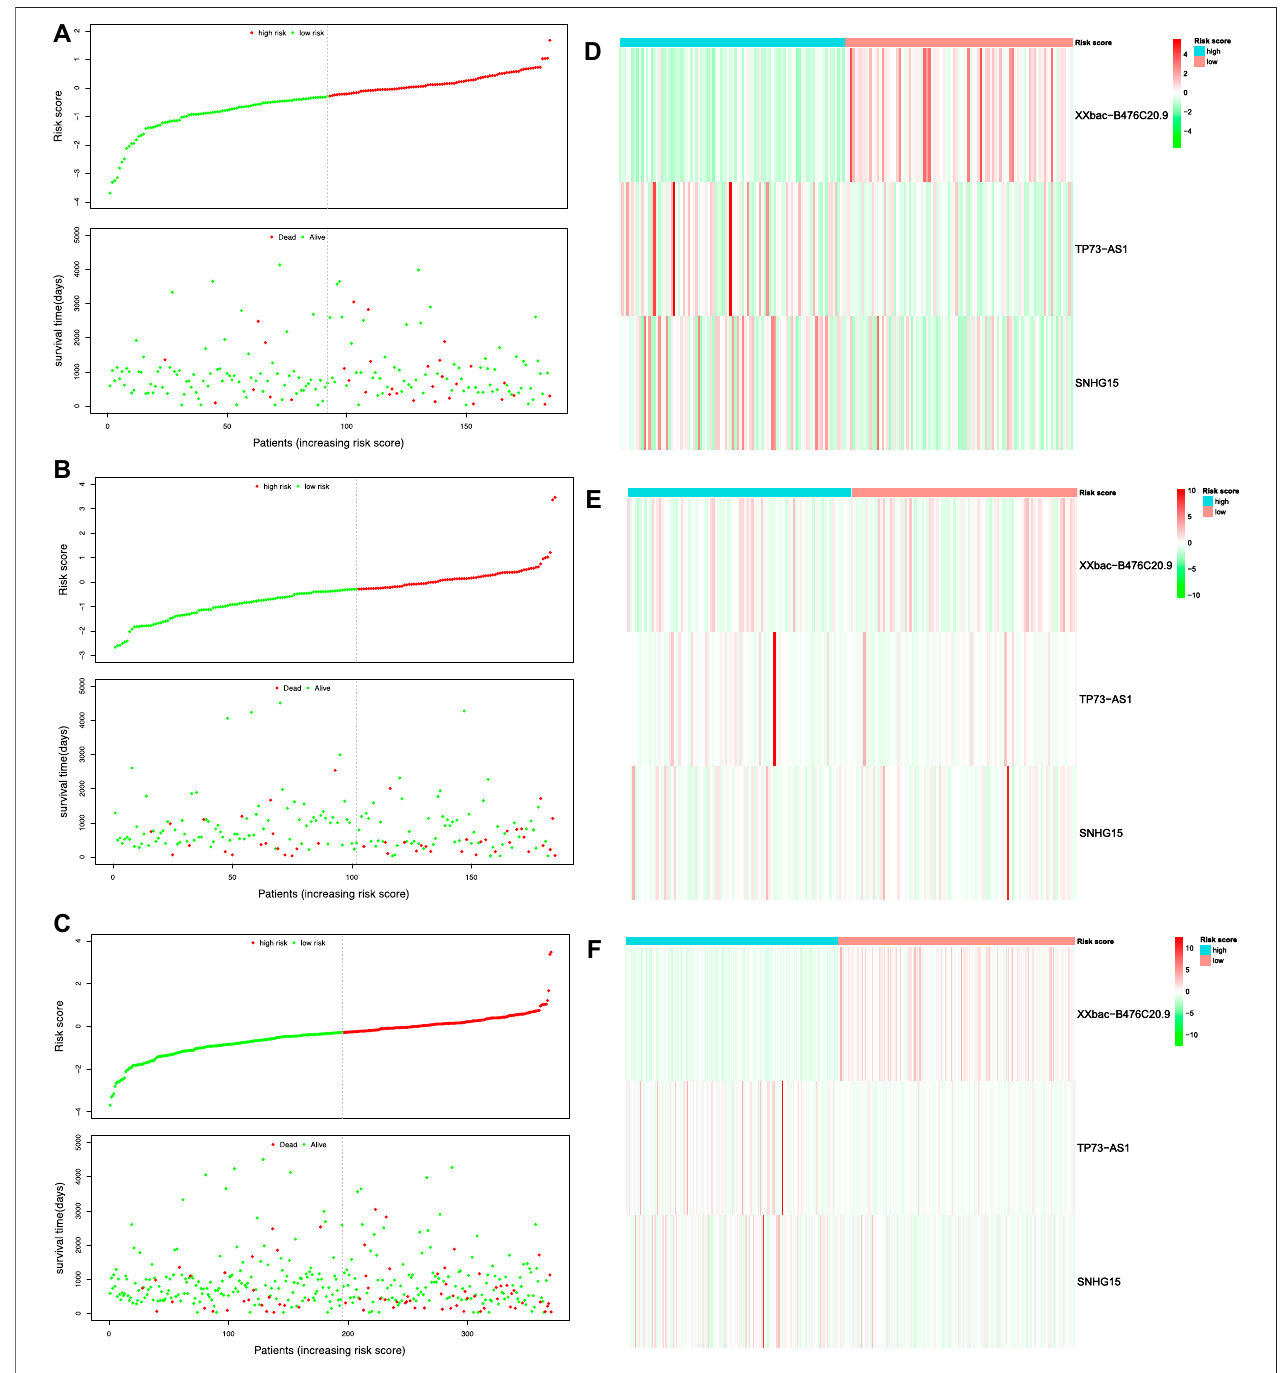
FIGURE4| RiskscoreanalysisoftheprognosticmodelinTCGA-COAD.Riskscoredistributionandsurvivalstatusofthepatientsinthetrainingset (A) ,testset (B) , and whole set (C) . Expression heatmap of three DEFR-lncRNAs in the training set (D) , test set (E) , and whole set (F) .